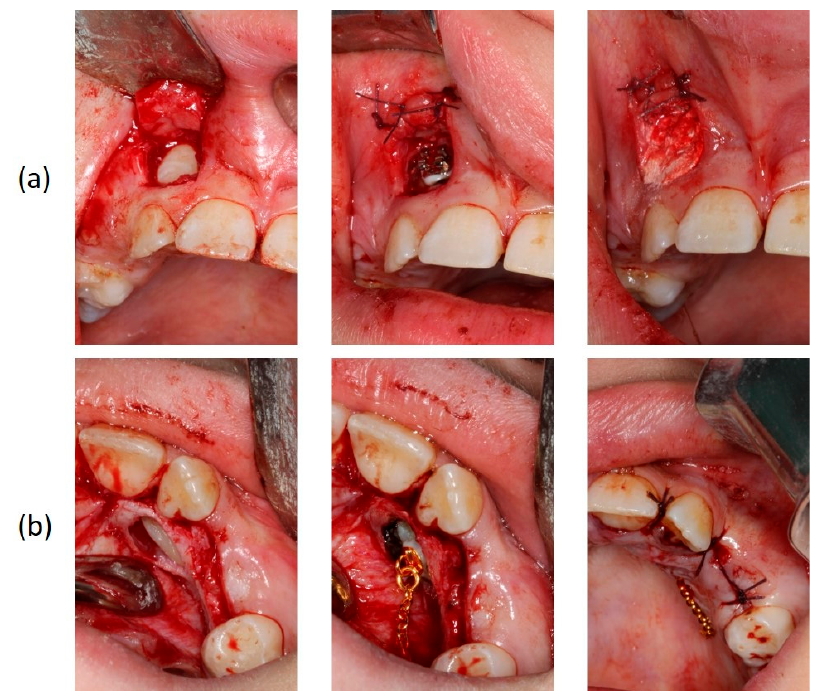
Figure 5. Surgical exposure of the upper right ( a ) and left impacted canines ( b ).